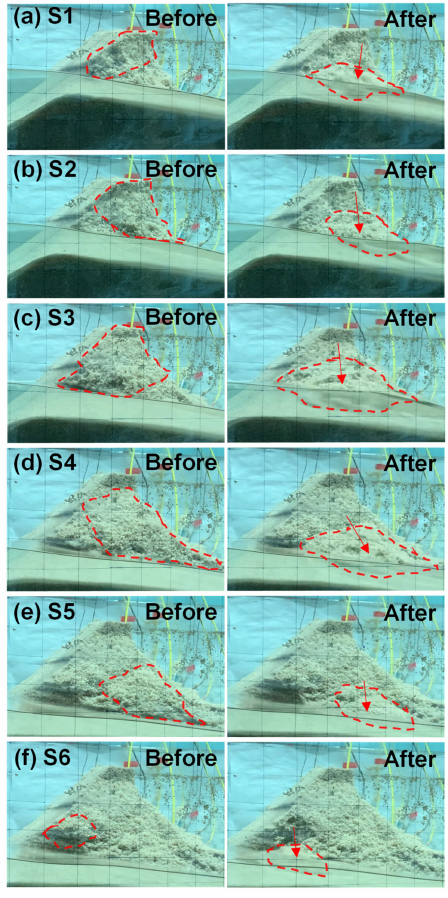
Figure 14. Before-and-after photos of the six lateral slides (S1–S6) of the dam at 607, 616, 632, 651, 670, and 677 s. The red dashed lines indicate the slid